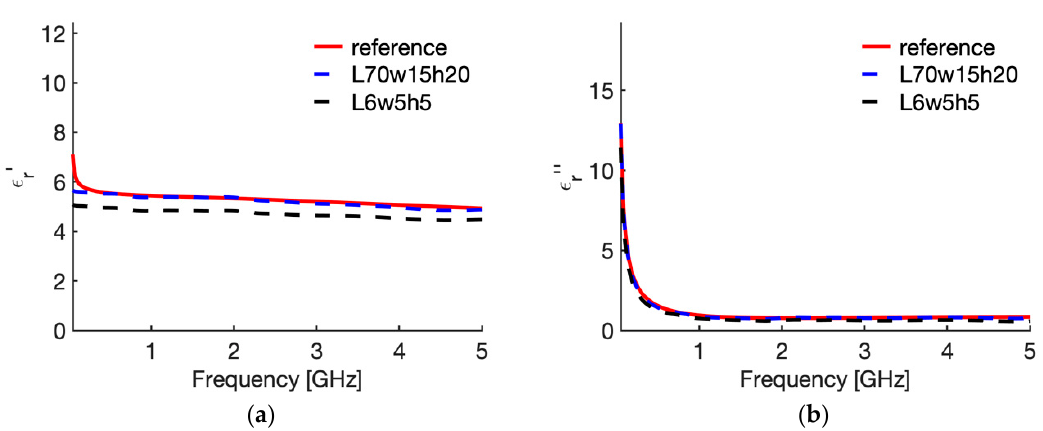
Figure 9. Relative complex permittivity of fat at 25 °C. ( a ) real part; ( b ) imaginary part. The values implemented into the CST software (red line) are compared with those reconstructed by the S&S model from the simulated reflection coefficient of the open probe in the reference case (dashed blue line), and in the case in which the maximum percentage error was evaluated (dashed black line, 6; 5; 5; air).